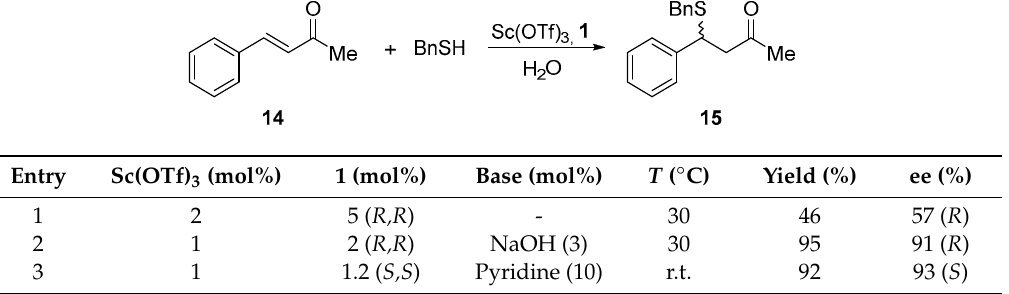
Table 4. Conjugate addition of benzylthiol on α , β -unsaturated ketone 14 .